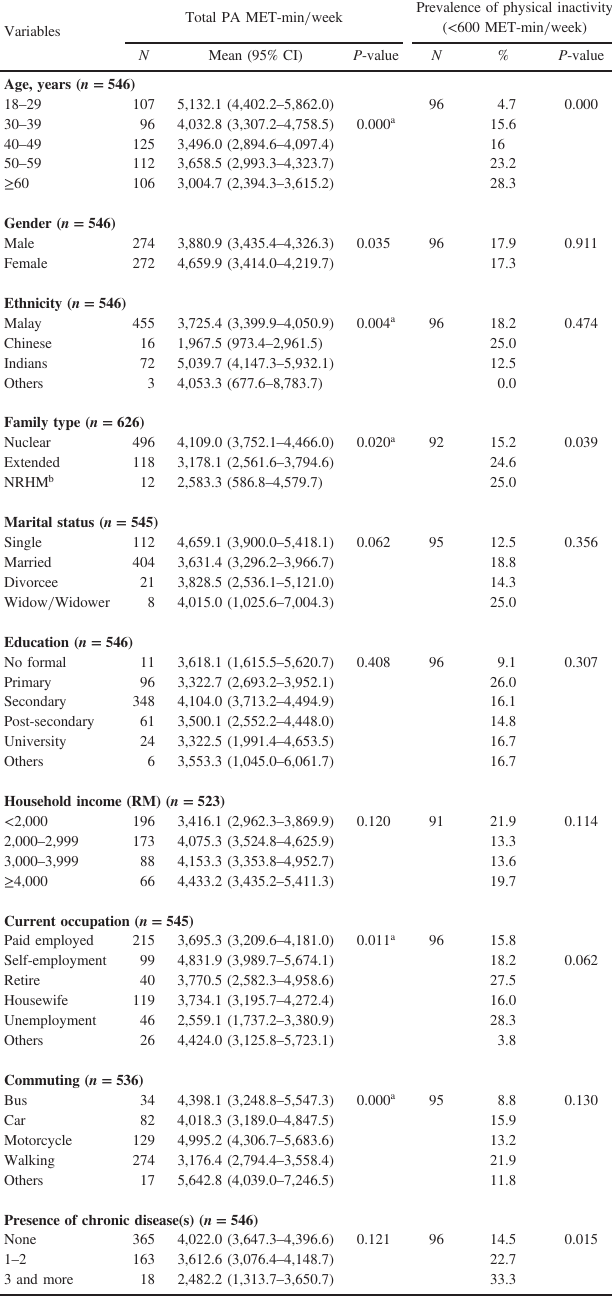
Table 1. Variation of physical activity and the prevalence of physical inactivity level by socio-economic factors Total PA MET-min = week Prevalence of physical inactivity (<600 MET-min = Variables